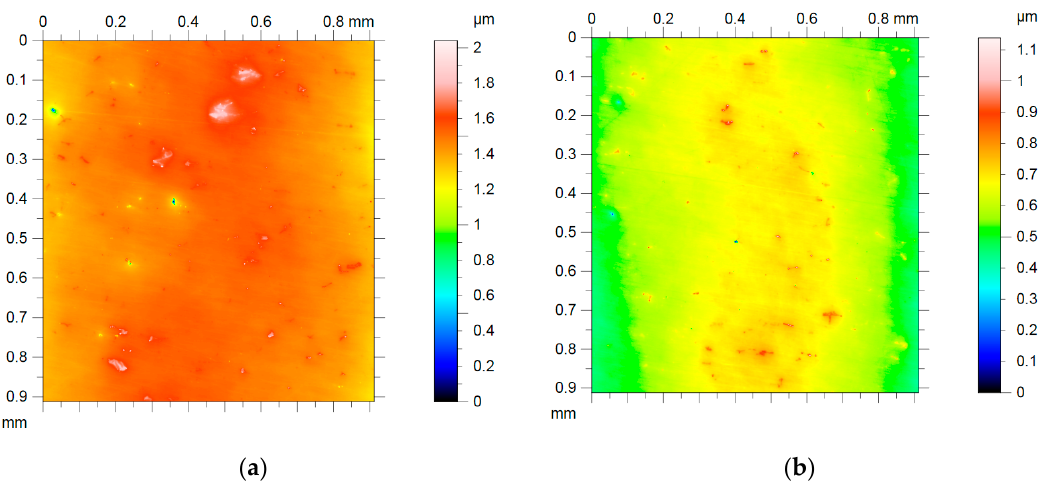
Figure 17. Surface roughness measurement for five times of polishing before and after replacement of the polishing agent: ( a ) before changing the polishing agent; ( b ) after changing the polishing agent.